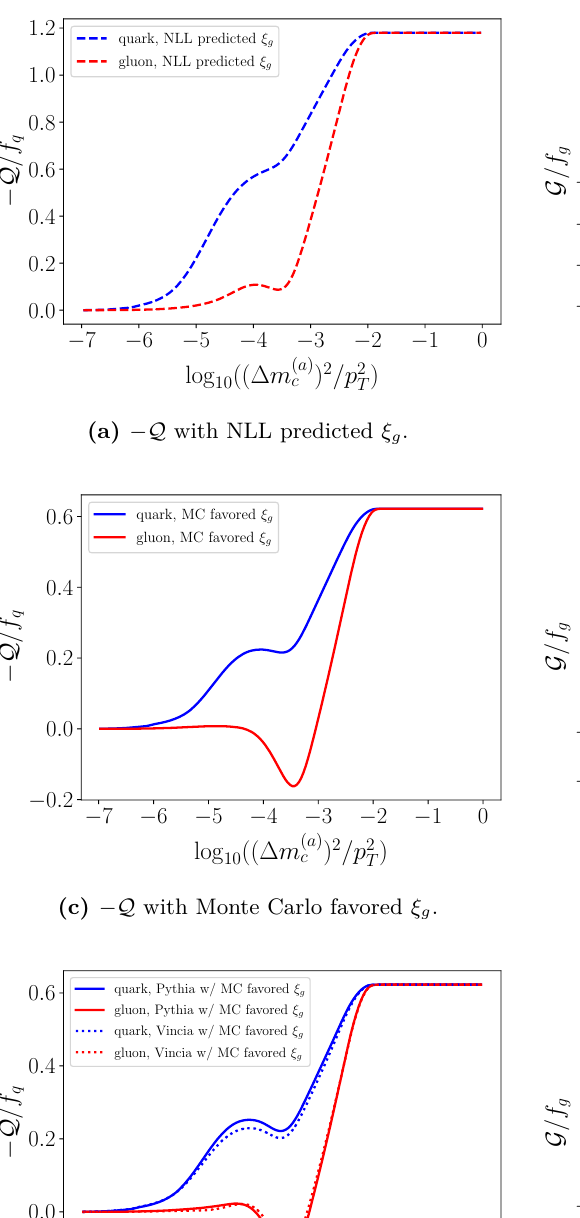
Figure 9. Monte Carlo results for the pure quark and gluon observables with β 1 = β 2 = 0 , z ( a ) 0 . 1 , z ( a ) = 0 . 4 and z ( b ) = 0 . 02 from Pythia (with results also from Vincia in the bottom panels). cut2 cut1 The top and middle panels have ISR and MPI turned off. The dashed curves in the top panels use the ξ j predicted from our NLL resummation. The remaining panels with solid curves use the ξ j values chosen in the text, which better purify the quark and gluon observables in Pythia . The bottom panels have ISR and MPI effects turned